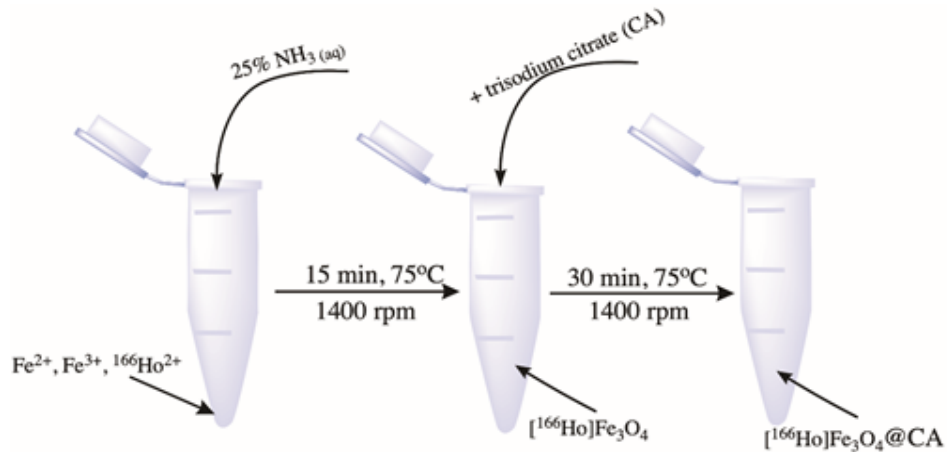
Figure 1. Scheme of precipitation synthesis and coating of [ 166 Ho]Fe 3 O 4 .